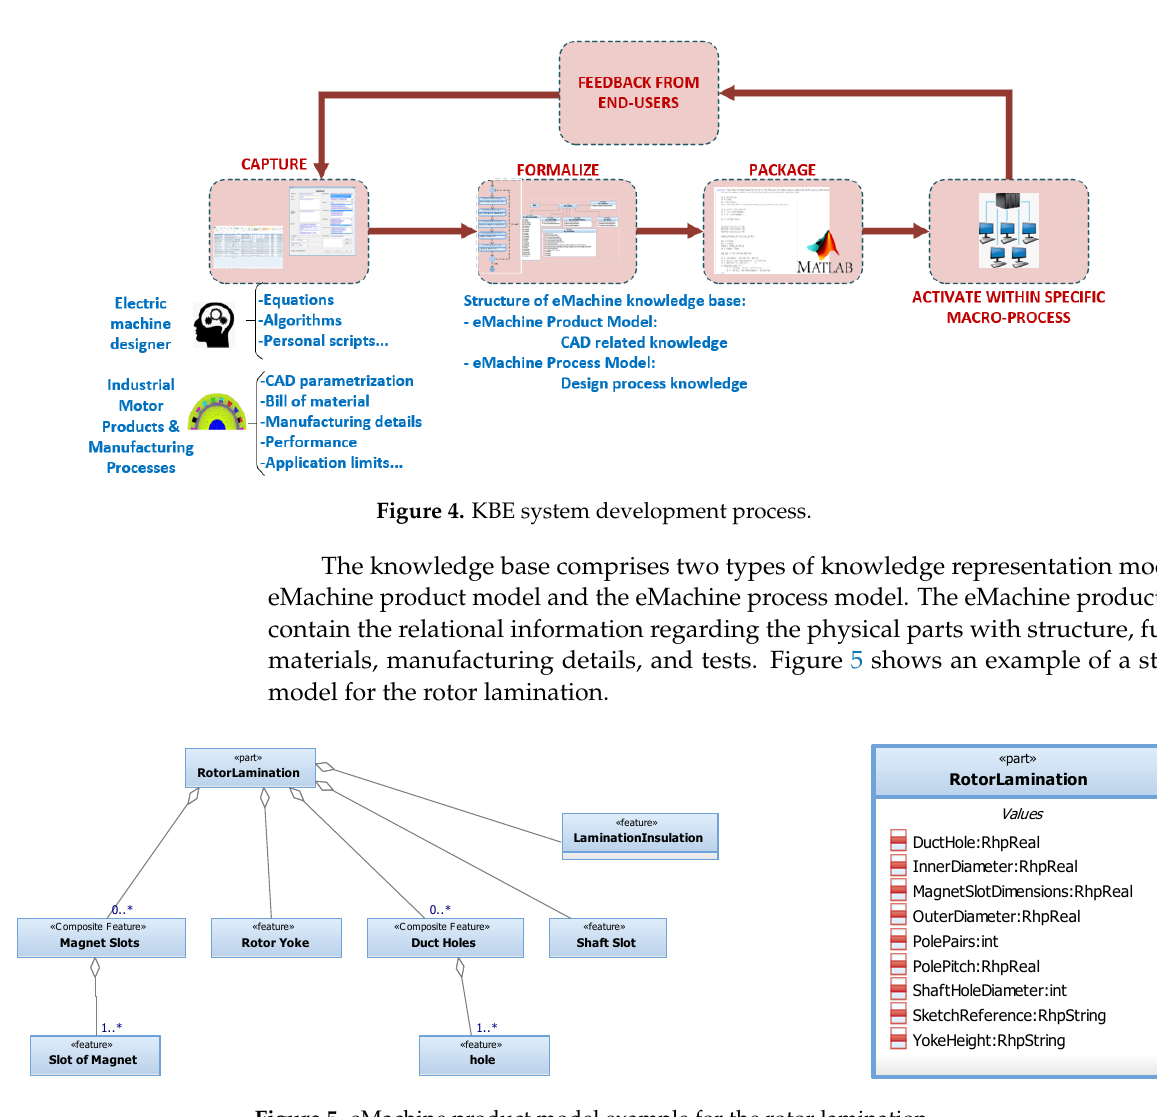
Figure 6. Macro-level and micro-level process knowledge representation illustration. The reuse of knowledge through already-developed scripts by the designers was ex- ecuted. It is known that companies already have software tools that are implemented within their standard processes. The KBE system should be flexible enough to integrate the software tools that the company is currently using. That will allow a smoother inte- gration of the KBE system among the personnel already using the software tools and their processes. Hence, the proposed software architecture is presented in Figure 7. This archi- tecture groups state of the art technologies mostly implemented in industry to cover the product development process. In other words, the KBE system consists of the integration of KBE applications with the rest of the technologies in the product development process. The architecture shows that the KBE application communicates with the other technolo- gies through middleware. Of course, depending on the objective, some technologies may not be part of it.